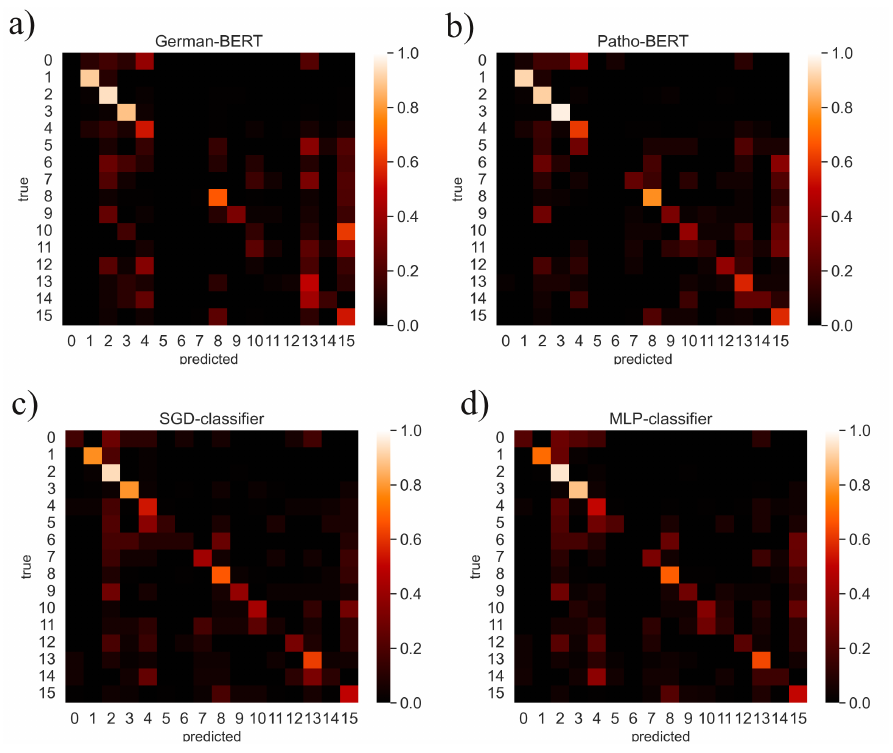
Figure 3. Confusion matrices of the classification models. ( a ) German-BERT, ( b ) Patho-BERT, ( c ) the SVM! ( SVM! )-based SGD-classifier, and ( d ) the MLP! ( MLP! )-classifier. The brightness of a cell indicates how many times the class on the x-axis was predicted by the classifier. The true class is indicated by the index of the y-axis. Interestingly, there are classes that could be recognized well by all classifiers, including the weaker ones, e.g., class 1 ( rapid progressive glomerulonephritis ), 2 ( tubulo-interstitial nephritis ) and 3 ( pauci immune glomerulonephritis ). Although the transformer-based classifiers ( a , b ) generally performed better, the BoW! -based methods were able to detect class 0 ( systemic lupus erythematosus ) or 5 ( fsgn ) better ( c , d